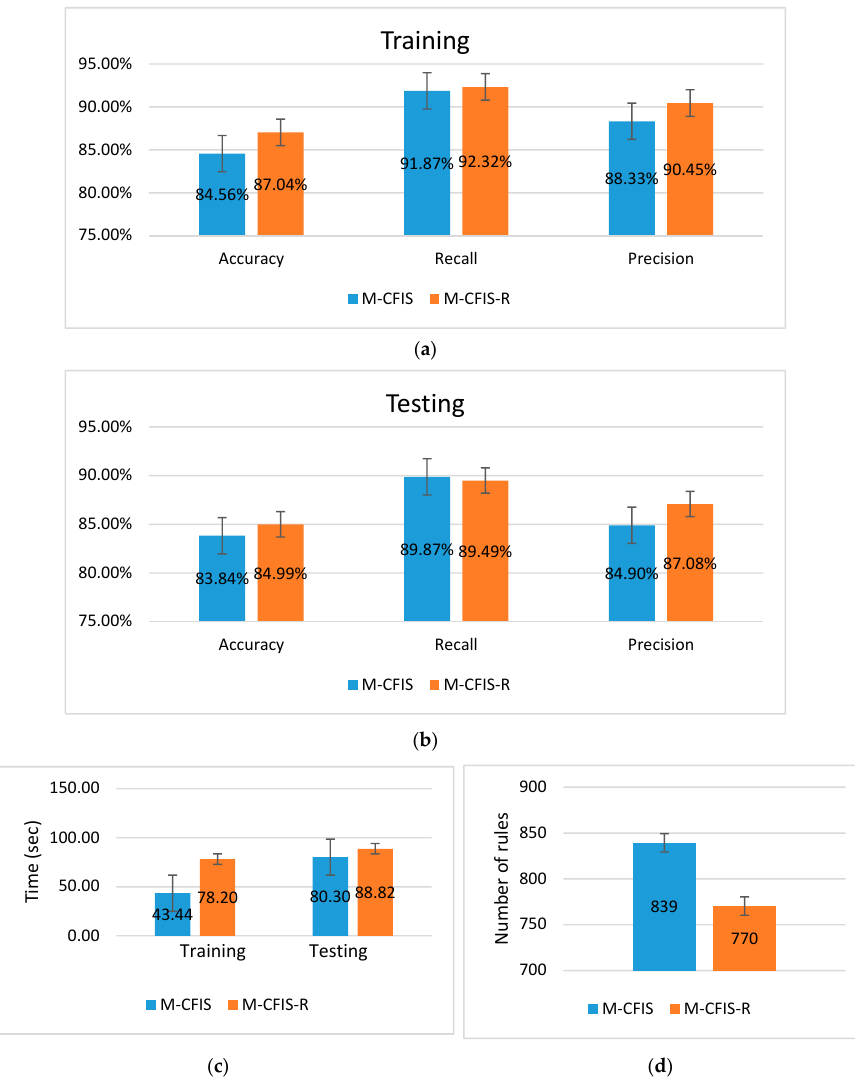
Figure 6. Performance on the Liver dataset: ( a ) Accuracy, Recall, Precision on training set; ( b ) Accuracy, Recall, Precision on testing set; ( c ) Time consumed; ( d ) Number of rules.